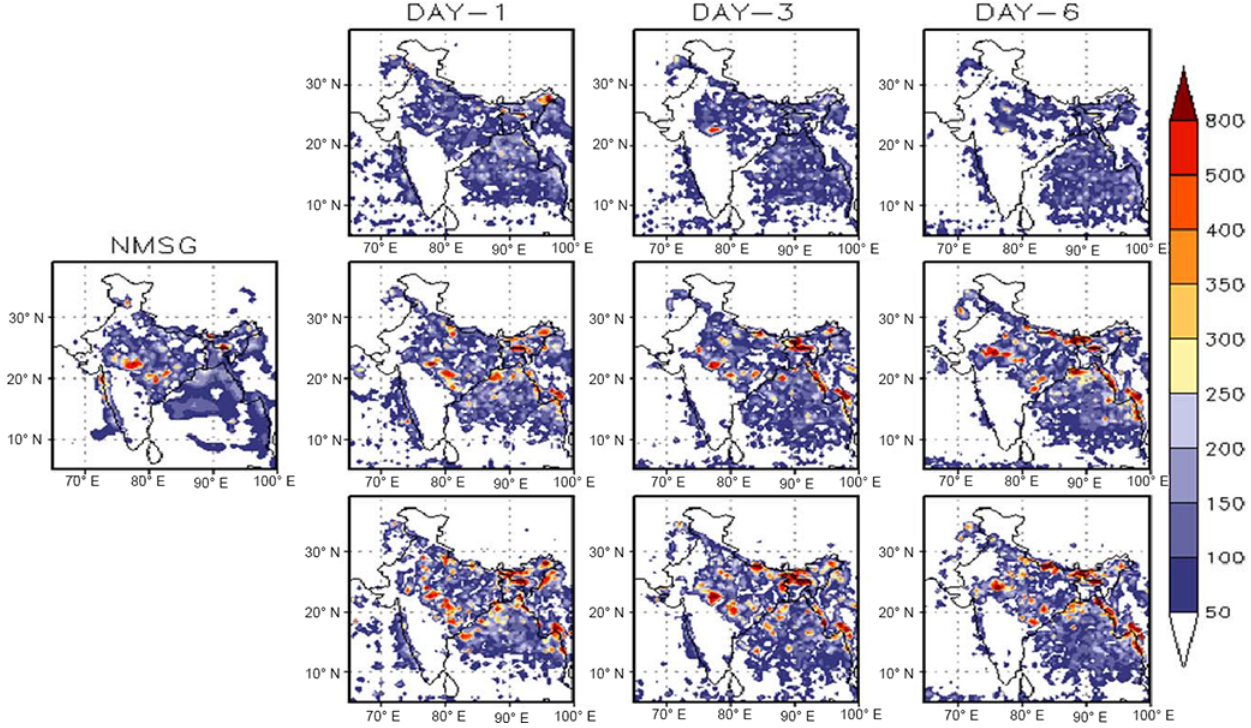
Figure 15. Variance of daily rainfall (mm 2 day − 2 ) for a 72-day period during data assimilation trials in July–September 2012. The observa- tions (on the left) are from the Indian National Centre for Medium Range Weather Forecasting (NCMRWF) merged satellite gauge (NMSG) product (Mitra et al., 2009). The model data to the right of this are from N512 GA3.1 forecasts (top), N512 GA6.1 (centre) and N768 GA6.1